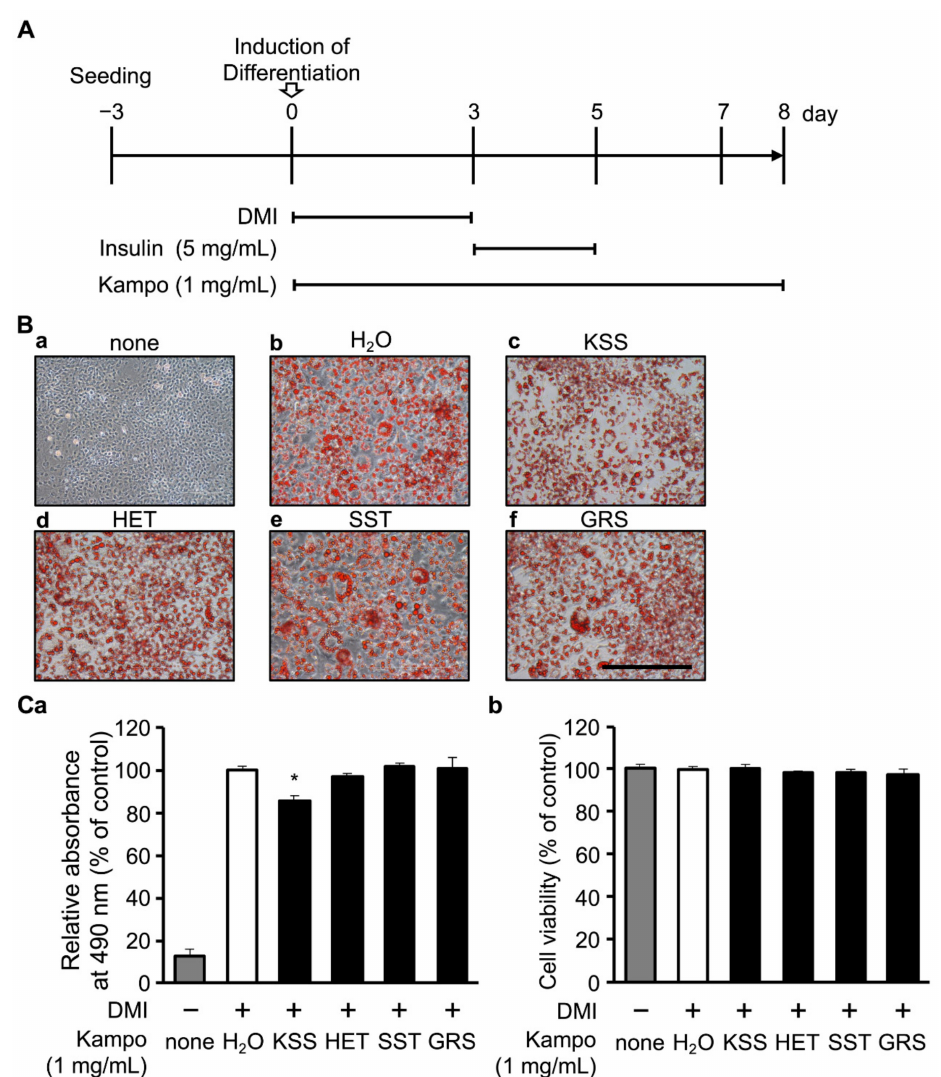
Figure 1. Kamishoyosan (KSS) reduces lipid accumulation. ( A ) Induction time course of 3T3-L1 cell di ff erentiation. 3T3-L1 cells were seeded on a 24-well plate at 2 × 10 4 cells per well and cultured for 3 days. After confluent (0 day), 1 µ M dexamethasone (Dex; D), 0.5 mM 3-isobutyl-1-methylxanthine (IBMX; M), and 10 µ g / mL insulin (I) were added to induce di ff erentiation for 3 days followed by additional 2 days culture with 5 µ g / mL insulin (day 3–5). Thereafter, the medium was changed to normal Dulbecco’s modified Eagle’s medium (DMEM) every 2 days (day 5–8). Kampo medicines were administered at a concentration of 1 mg / mL after the onset of di ff erentiation (day 0–8). ( B ) Images of Oil-Red-O staining of 3T3-L1 cells on day 8 are shown. ( Ba ) None (no DMI di ff erentiation induction). ( Bb–f ) control and Kampo medicine administration groups (( Bb ); H 2 O ( Bc ); KSS, ( Bd ); Hochuekkito (HET), ( Be ); Shoseiryuto (SST), ( Bf ); Goreisan (GRS) with DMI di ff erentiation induction). The scale bar indicates 200 µ m. ( C ) KSS suppresses lipid accumulation. ( Ca ) Oil-Red-O dye was extracted with isopropanol to measure intracellular lipid accumulation, and the absorbance was measured at 490 nm as compared with H 2 O (with DMI di ff erentiation induction). ( Cb ) Cell viability after 8 days of culture was evaluated with the CCK-8 assay. Absorbance measured at 450 nm is shown as relative absorbance to H 2 O (with DMI di ff erentiation induction). Data are shown as the mean ± standard deviation ( n = 3). * p < 0.05 vs. H 2 O (with DMI di ff erentiation